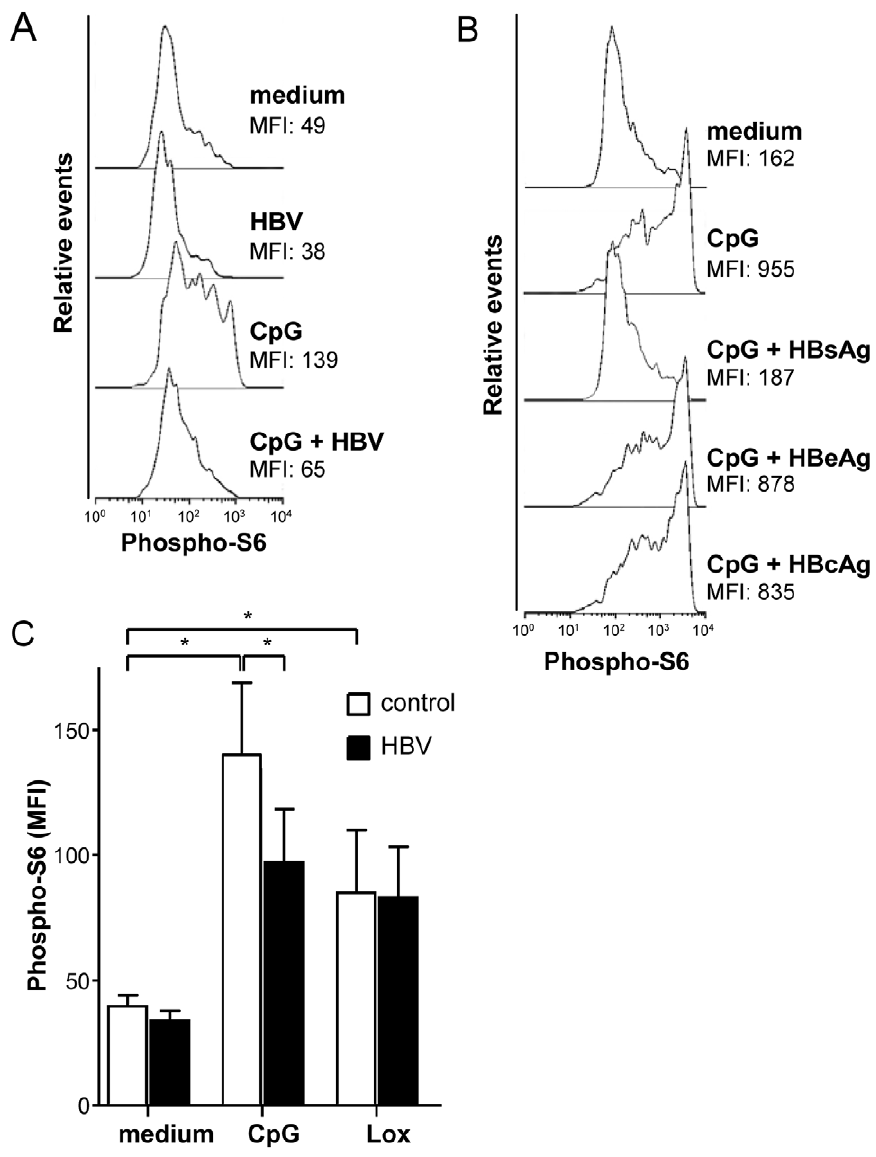
Figure 7. HBV and HBsAg inhibit CpG-induced S6 phosphorylation. A : pDC were cultured with CpG in the presence or absence of HepG2.215-derived HBV. Data show the expression of phosphorylated S6 and the mean fluorescence intensity (MFI) and are representative for 8 independent experiments. B : pDC were cultured with or without CpG in the presence or absence of HBcAg, HBeAg, or HBsAg. Data show expression of phosphorylated S6 and the MFI and are representative for 3 independent experiments. C : Data show mean 6 SEM expression of phosphorylated S6 in BDCA4 + CD123 + pDC in PBMC exposed to CpG or Lox in the presence or absence of HepG2.215-derived HBV from 6 independent experiments. *p , 0.05, Wilcoxon signed rank